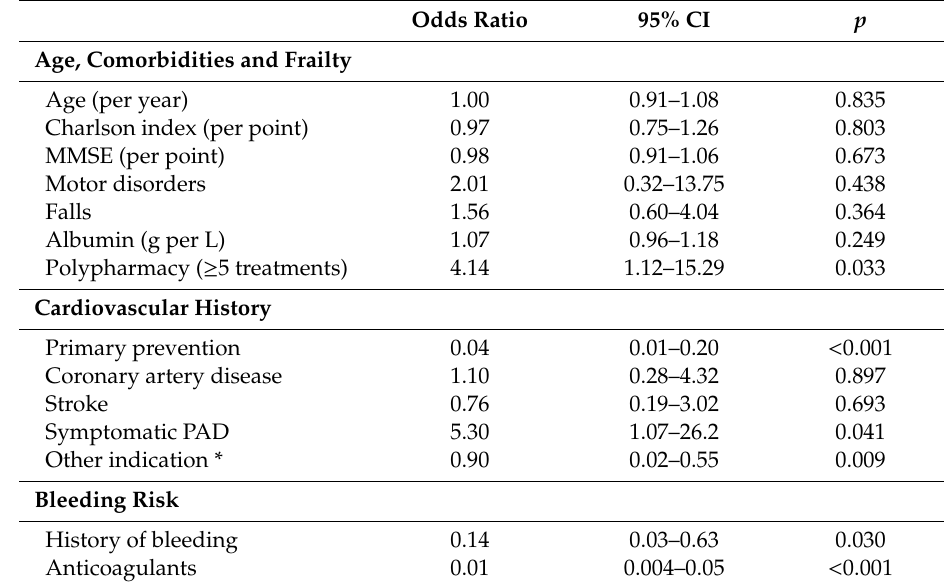
Table 2. Multivariate analysis of factors associated with prescription of platelet aggregation